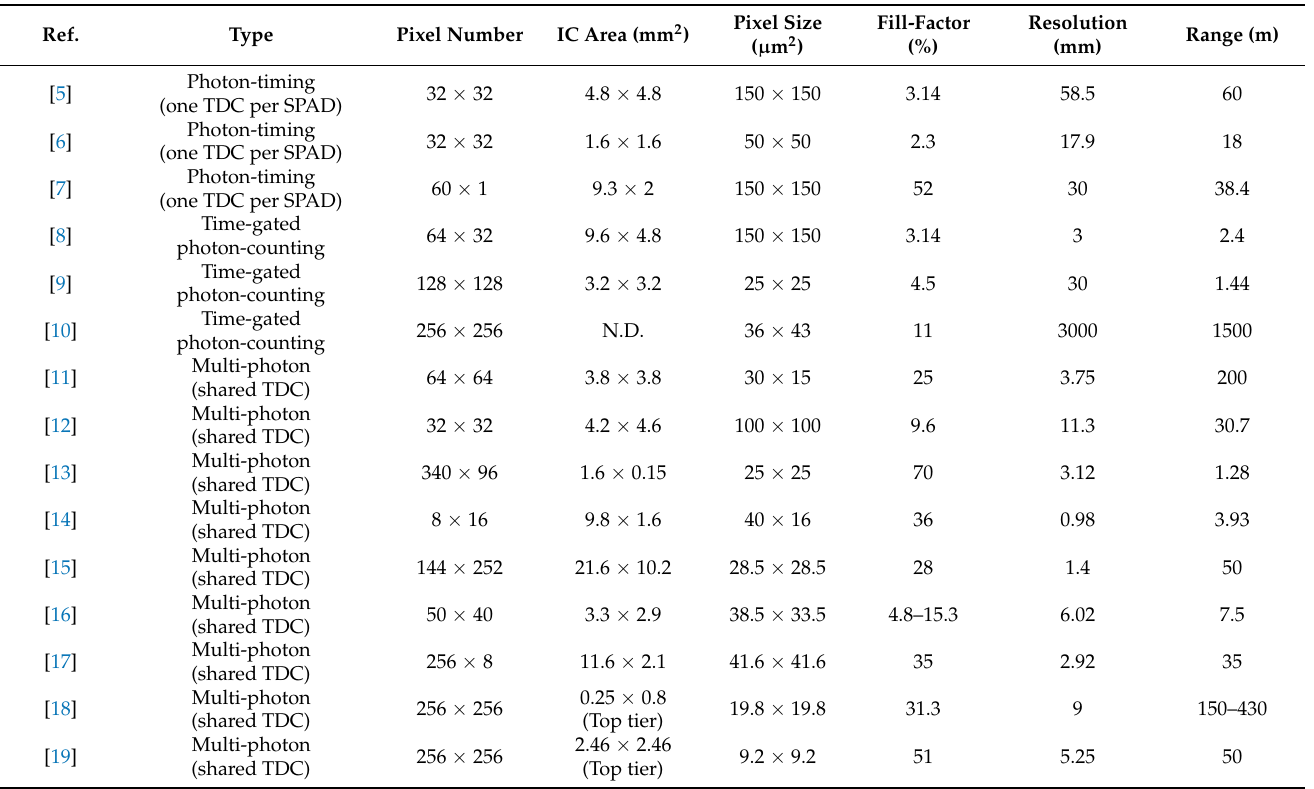
Table 1. State-of-the-art of SPAD imagers for TOF-LiDAR.